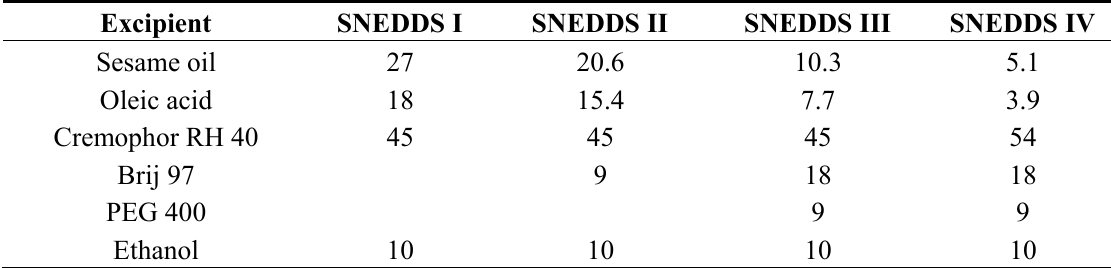
Table 4. Composition of SNEDDSs ( w / w